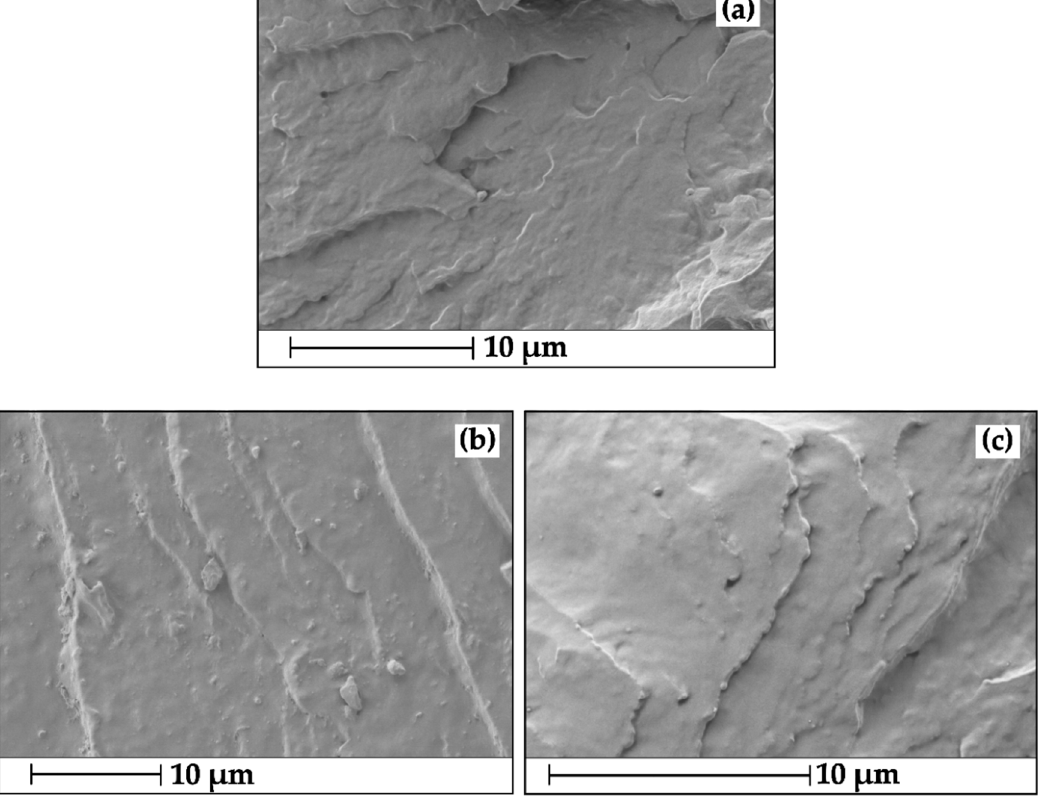
Figure 2. Scanning electron microscopy micrographs of ( a ) PBAT, ( b ) PBAT-5GR, ( c ) PBAT-5UT, ( d ) PBAT-10GR, ( e ) PBAT-10UT , ( f ) PBAT-15GR, and ( g ) PBAT-15UT.